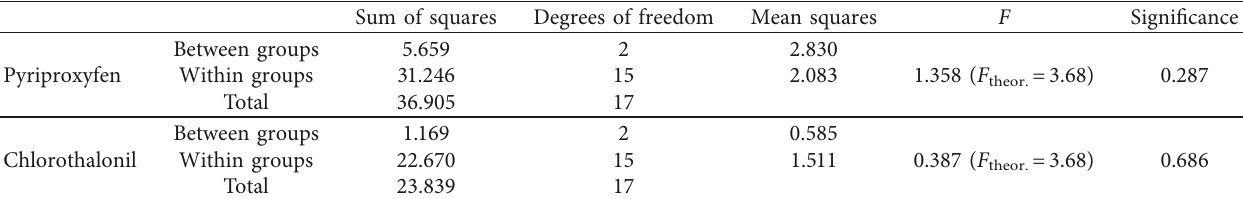
Table 5: One-way ANOVA statistical analysis results of pyriproxyfen and chlorothalonil by three proposed methods in laboratory prepared mixtures.